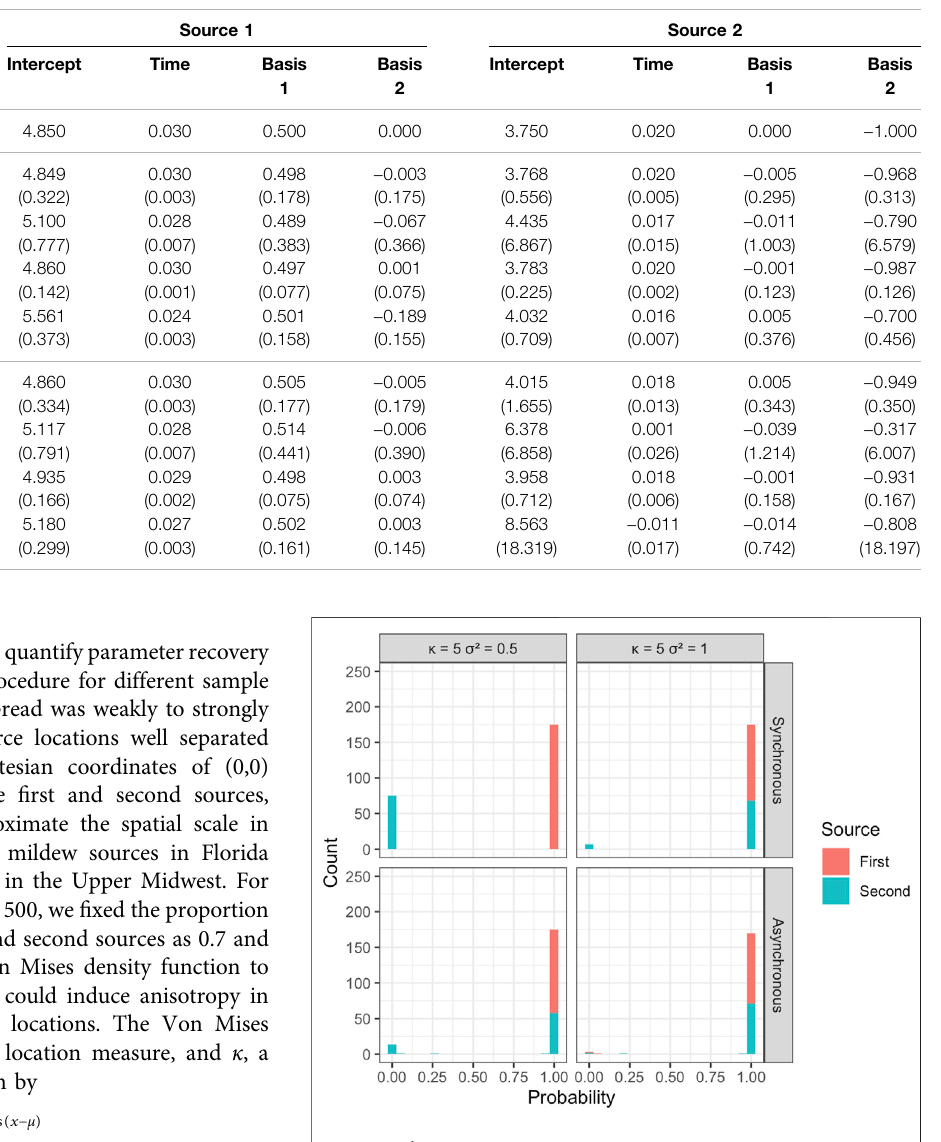
FIGURE 5 | Estimated probability of disease source for each of the n (cid:1) 250 observations in individual, representative simulations with κ (cid:1) 5 and σ 2 (cid:1) 0.5 and 1. Results are shown for temporally synchronous and asynchronous epidemics.